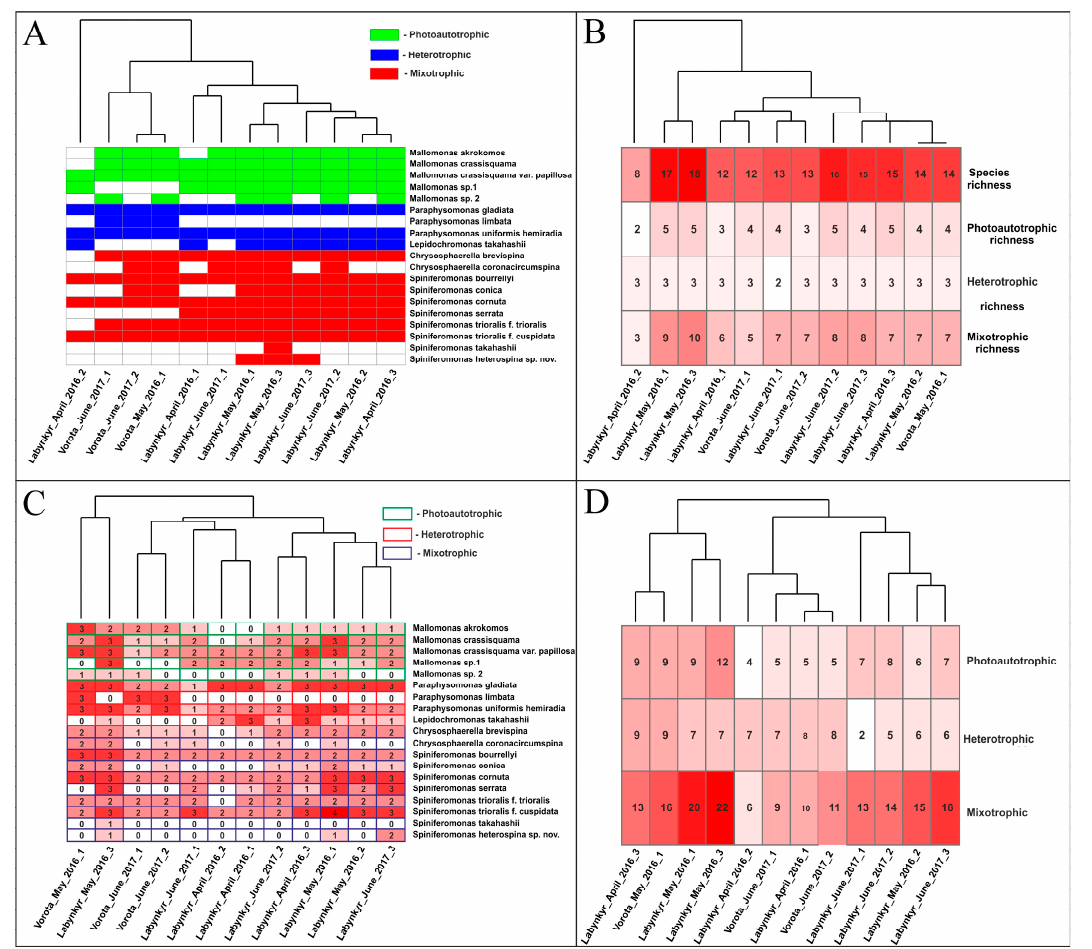
Figure 5. Analysis of similarities and differences between the studied samples ( A ) by species composition (clustering based on Jaccard distances); ( B ) by indicators of species richness of different groups of species (clustering based on Euclidean distances), where the species richness value is indicated in cells; ( C ) by indicators abundance of different groups of species (clustering based on Euclidean distances), where the cells indicate the value of the species abundance; and ( D ) by cumulative abundance of different species groups (clustering based on Euclidean distances), where the cells indicate the value of cumulative species abundance for species groups.